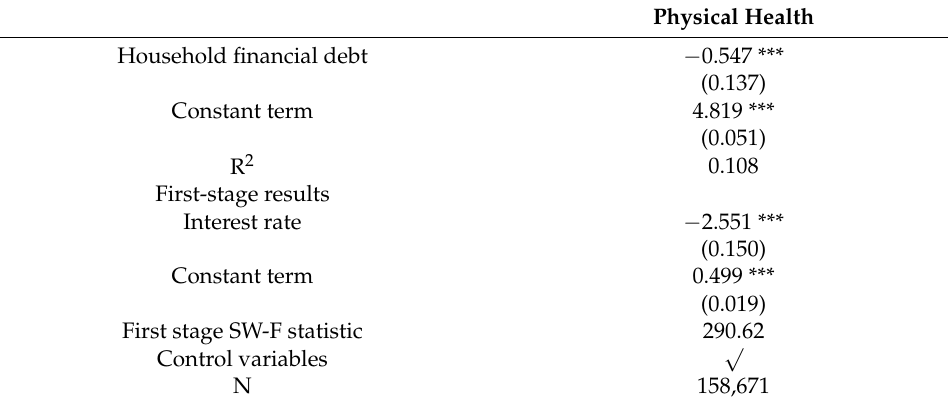
Table 4. Regression results for instrumental